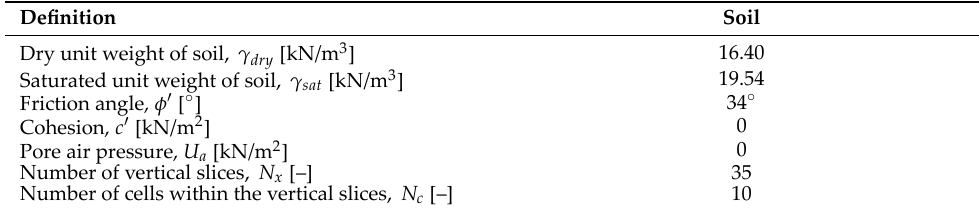
Table 4. Model parameters for slope stability